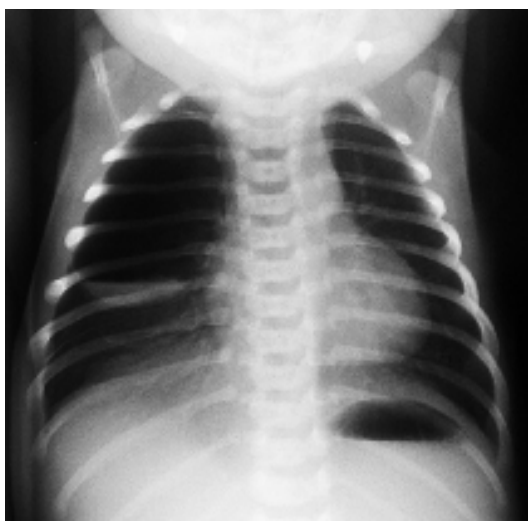
Figure 2 Cystic adenomatoid malformation (CAM). Chest radiograph of a female newborn with a CAM in the left lower lobe. The malformation caused a shift of the mediastinum, and the baby presented with tachypnoea and shortness of breath.